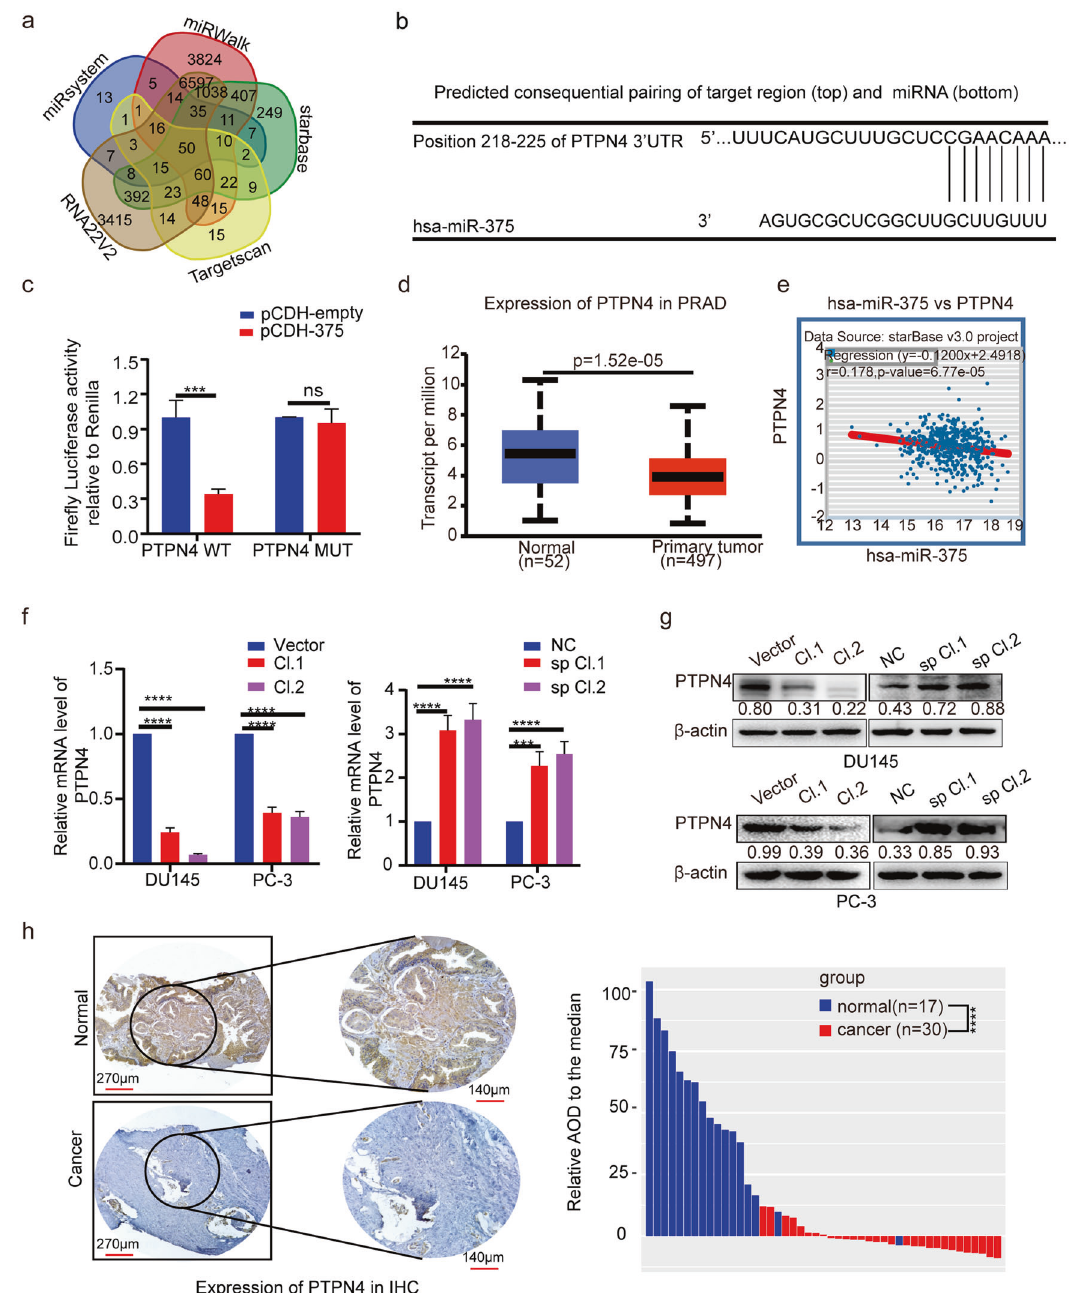
Fig. 3 MiR-375 targeted and negatively regulated PTPN4 in PCa. a Potential target genes were predicted using the miRsystem, miRWalk, StarBase, TargetScan and RNA22v2 databases. A total of 50 genes were found to be shared in the fi ve databases. b The potential binding site of miR-375 with the 3 ′ -UTR of PTPN4 was predicted using the TargetScan database. Complementary sequences consisting of 8 nt were aligned and presented. c A luciferase assay was conducted to validate the direct binding and modulating function of miR-375 to the 3 ′ -UTR of PTPN4. PCDH-empty: HEK-293 cells transfected with the pCDH-CMV vector. PCDH-375: HEK-293 cells transfected with pCDH-CMV vector that was subcloned with a fragment of pri-miR-375. PTPN4 WT: HEK-293 cells cotransfected with the P-MIR-Report fi re fl y luciferase vector inserted with a fragment of the wild-type 3 ’ -UTR of PTPN4 mRNA. PTPN4 MUT: HEK-293 cells cotransfected with the P-MIR-Report fi re fl y luciferase vector subcloned with the 3 ′ -UTR of PTPN4 mRNA mutated at the complementary site. d The expression of PTPN4 in PCa tissues compared with normal prostate tissues from the UALCAN database. e The correlation between miR-375 level and PTPN4 in PCa, statistically processed by StarBase. r = − 0.178, p = 6.77e-5. PTPN4 at the mRNA level ( f ) and protein level ( g ), as determined by qRT-PCR and western blot in DU145 and PC-3 cells after miR-375 was overexpressed or knocked down. h IHC illustrating the differential expression of PTPN4 between 30 PCa and 17 normal tissues. The results show a representative IHC image (left) and quantitative analysis calculated by Image-Pro Plus version 6.0 software based on the 47 IHCs (right). AOD: average integrated optical